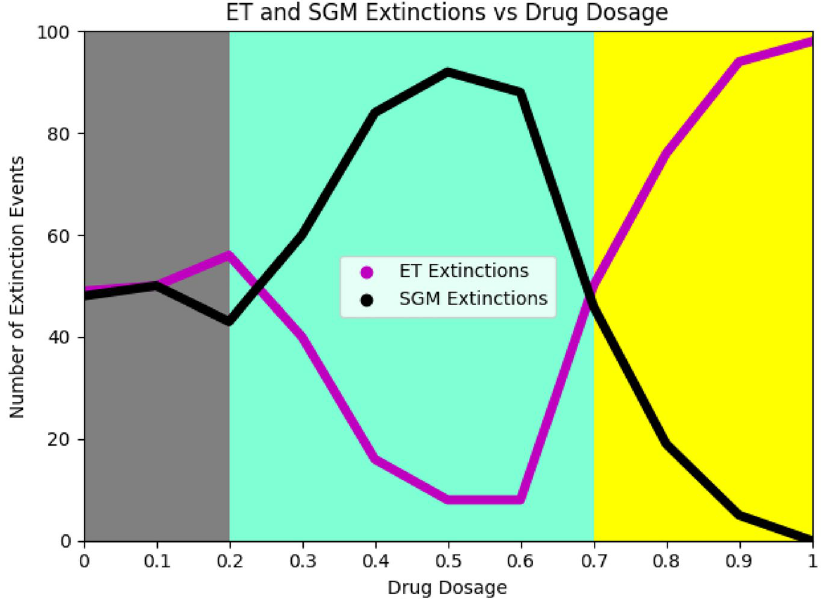
Figure 7. Extinction rates for evolutionary triage and self-genetic modification for various drug doses. ET is favored under low selection regimes and SGM is favored under high selection regimes. When external selection pressures are very low, SGM and ET mechanistically act in an identical